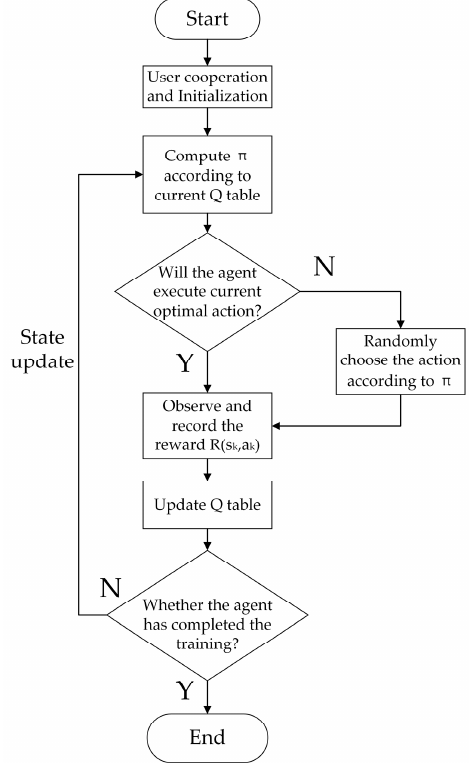
Figure 4. Algorithm flow chart.